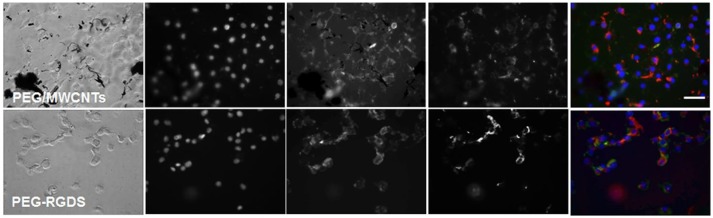
Fluorescence images of NIH 3T3 cells on fibronectin-coated PEG/MWCNTs and PEG-RGDS hydrogels at 2 h in serum-free medium. Nucleus was stained with Hoechst 33258 (blue), actin was stained with Alexa 488 phalloidin (green) and fibronectin was stained with polyclonal anti-fibronectin (red). Scale bar is 50 μm.